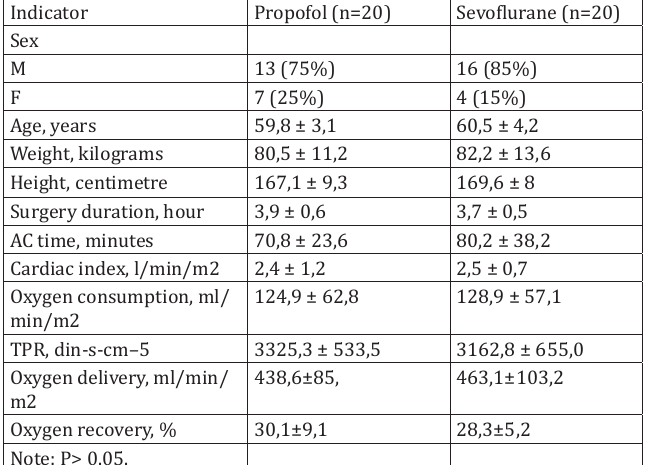
Demographic, anthropometric data, surgical volume, cardiac index, oxygen consumption, oxygen delivery and oxygen